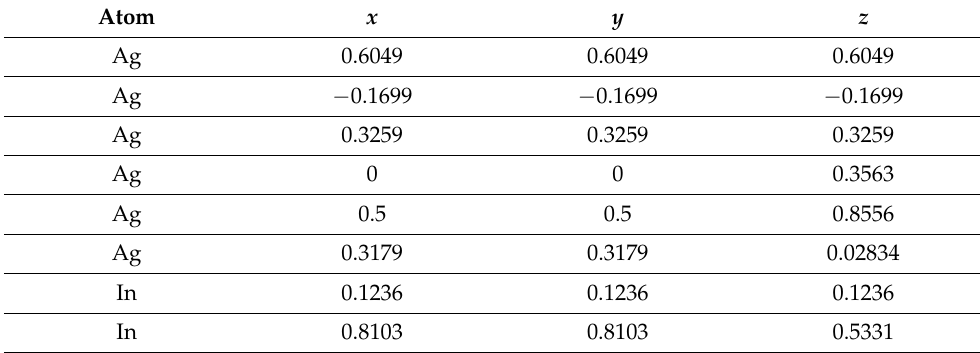
Table 2. Atomic coordinates for Ag 9 In 4 after relaxation.